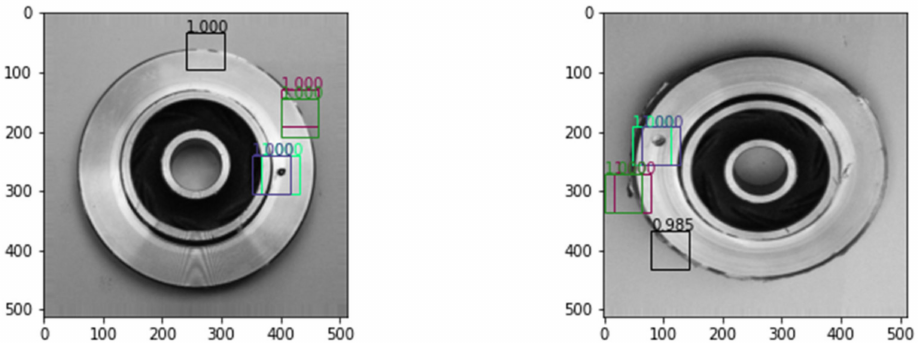
Figure 10. Localized defect detection with detection probability on two 512 × 512 sized